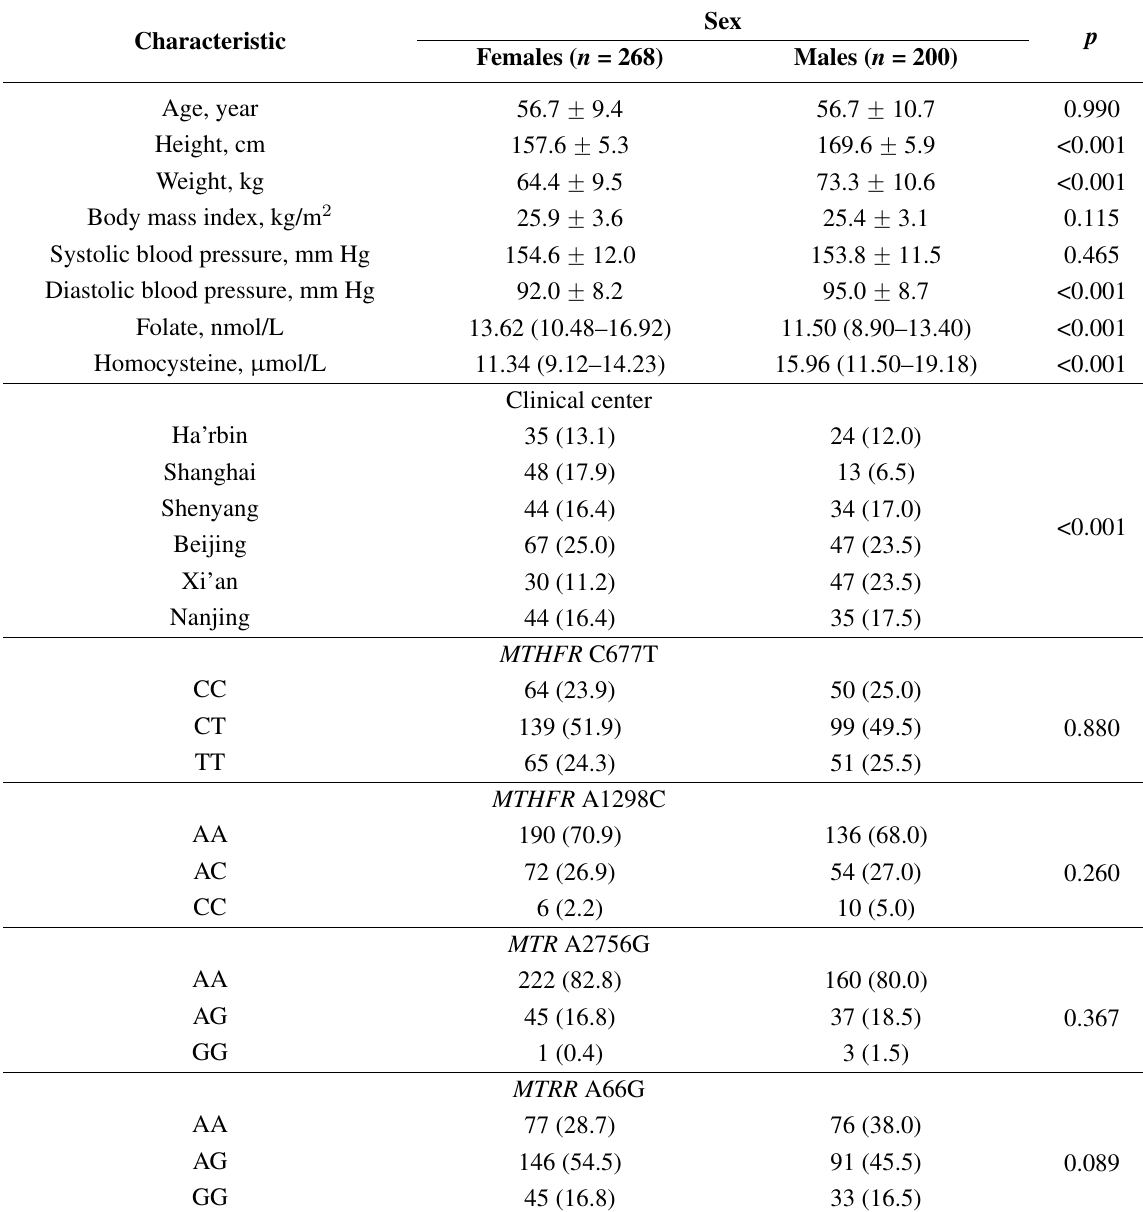
Table 2. Clinical and epidemiologic characteristics of the population grouped by sex.